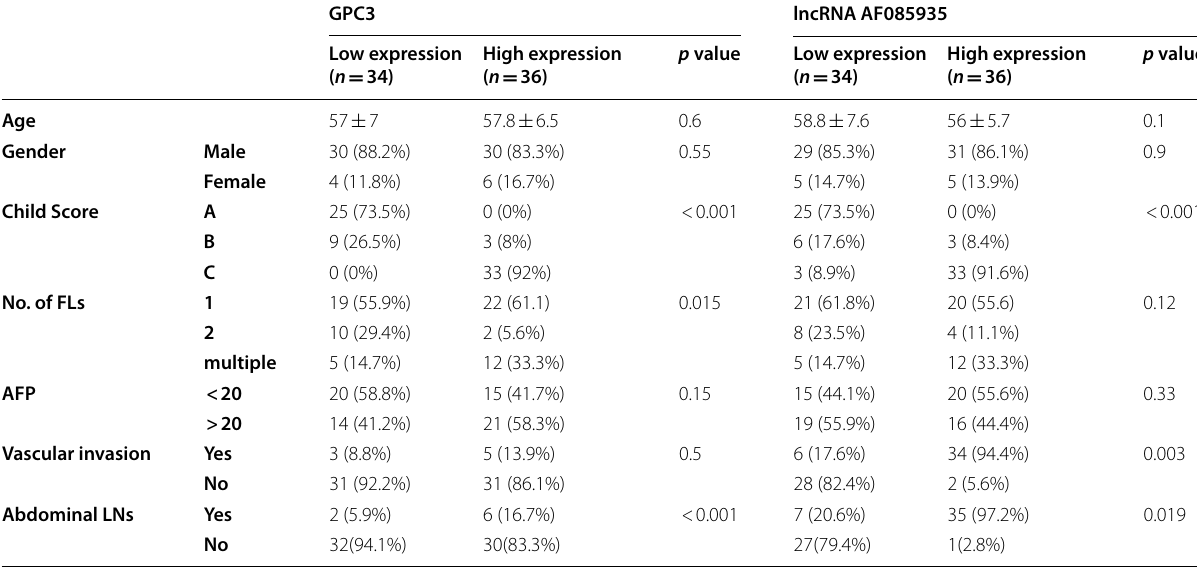
The median expression level was used as the cutoff. Low expression of lncRNA and GPC3 in 70 patients was defined as a value below the 50th percentile, and high expression was defined as a value above the 50th percentile